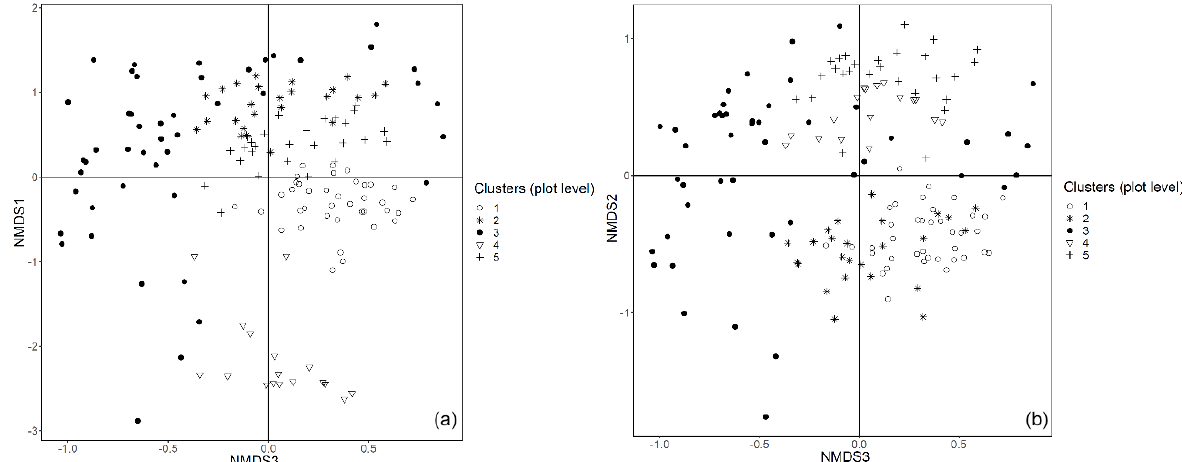
Figure E1. Plot data – NMDS ordination (axes 1 and 3, a ; axes 2 and 3, b ) of 154 plots across six sacred forests for canopy trees. Plots are labeled according to the five clusters produced by the cluster analysis (1: pine ( Pinus nigra ); 2: mixed oaks (dominated by Quercus coccifera and Q. frainetto ); 3: sclerophyllous species ( Acer monspessulanum, Q. coccifera , and Juniperus oxycedrus ); 4: beech ( Fagus sylvatica ); 5: mixed broadleaves ( Q. pubescens and Carpinus orientalis ).